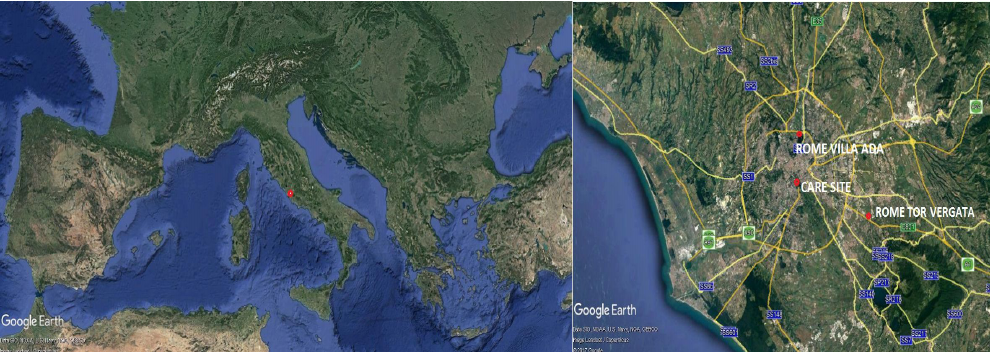
Figure 1. Measurement sites in the area of Rome and relevant datasets: Rome Tor Vergata (AERONET inferred eBC 2001–2017, in-situ measured equivalent black carbon (eBC) during ARTOV and DIAPASON (Desert-dust Impact on Air quality through model—Predictions and Advanced Sensors ObservatioNs) campaigns); CARE (Carbonaceous Aerosol in Rome and Environs) site (in-situ measured eBC during CARE campaign); Rome Villa Ada (PM 2.5 and